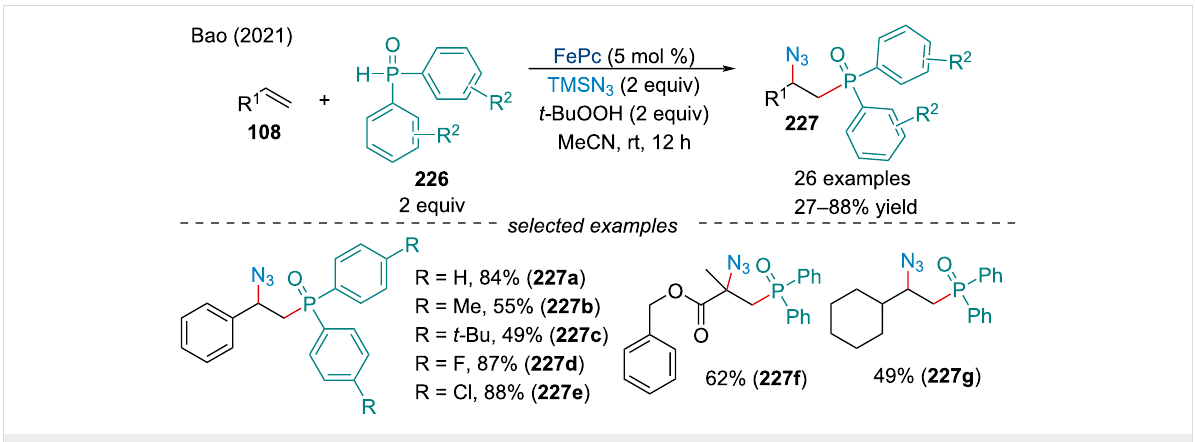
aminochlorinating reagents, applicable for late-stage functional- ization. In contrast to their previous report, the reactions displayed broad reactivity and worked well for unactivated internal alkenes. To illustrate the versatility of this protocol, the authors synthesized a chlorinated fomocaine analog in three